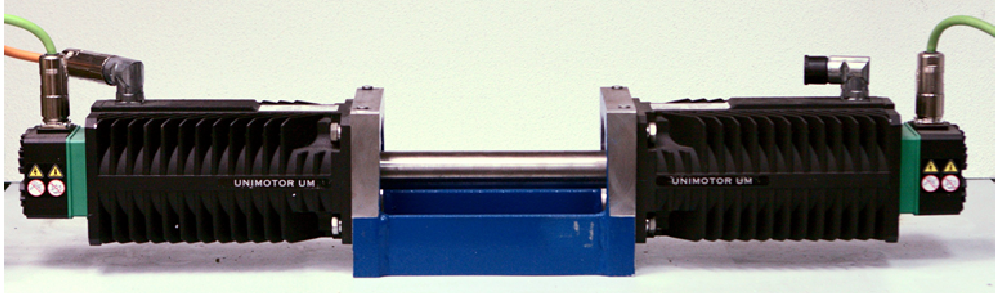
Figure 4. Mechanical setup: twin PMSM with a stiff